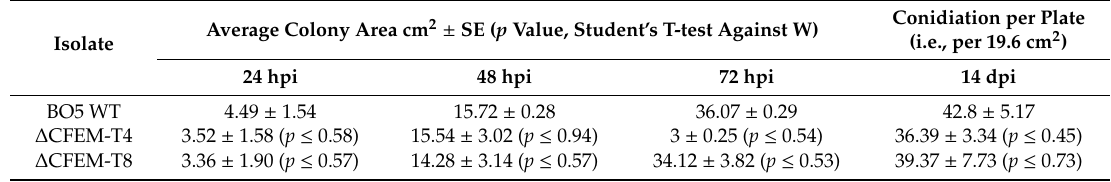
Table 3. Growth and sporulation in the BO5 WT and CFEM deletion